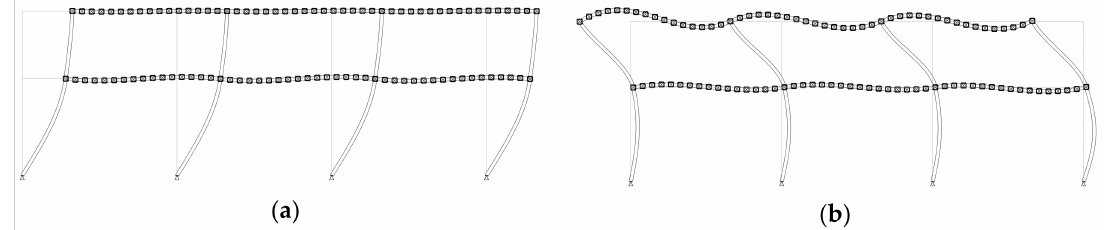
Figure 15. Two first in-plane sway buckling modes of the examined frames. ( a )—1st sway buckling mode; ( b )—2nd sway buckling mode.